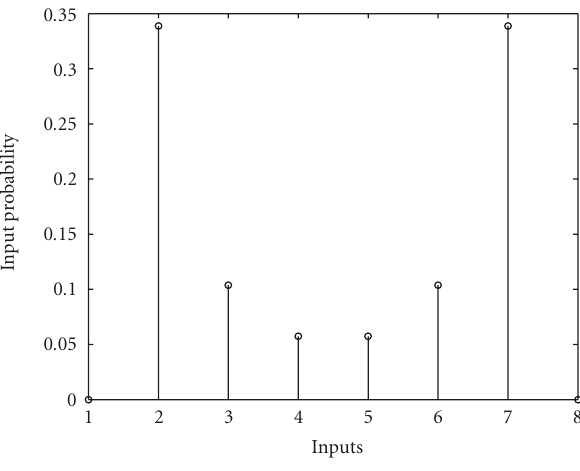
Figure 8: A maximizing input distribution at high SNR for the SISO channel.